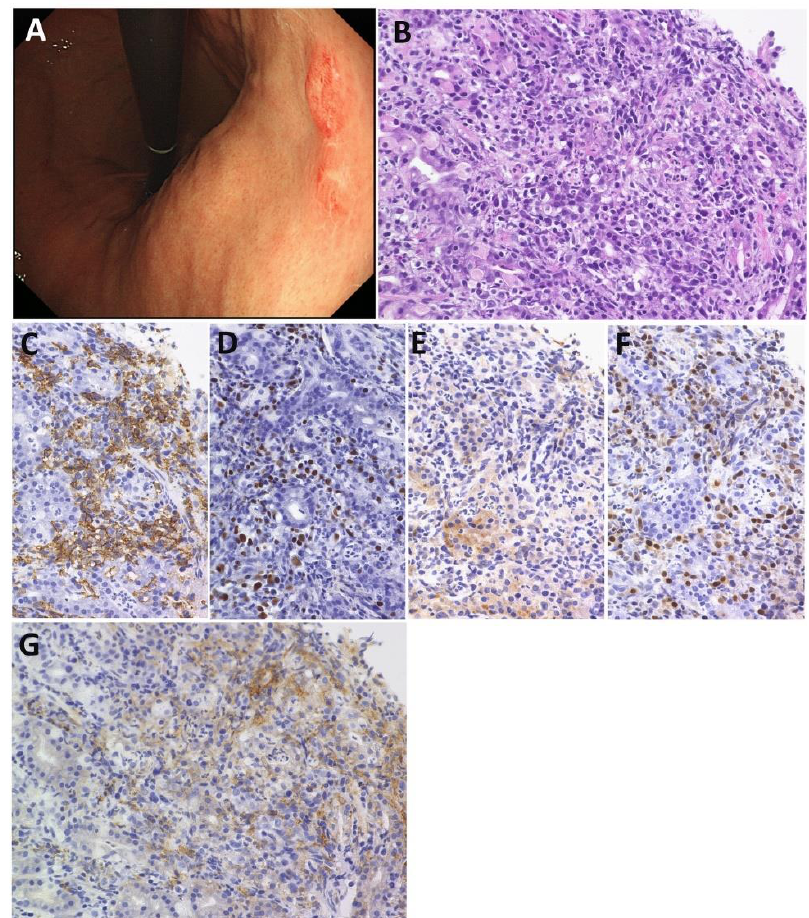
Figure 1. Histological features of EBV-positive mucocutaneous ulcer (EBVMCU). ( A ) Endoscopic image revealing small shallow ulcers in the stomach. ( B ) The infiltrate is polymorphous, containing lymphocytes, histiocytes, and immunoblasts, but not Hodgkin-like cells. ( C ) The scattered large cells were positive for CD20, ( D ) EBER, ( E ) CD30, and ( F ) MUM1. ( G ) PD-L1 is expressed on nonmalignant immune cells, but not on tumor cells. Original magnifications: ×200 ( B – G ). 4. EBV-Positive Diffuse Large B-Cell Lymphoma (EBV + DLBCL) EBV + DLBCL, NOS was first described in Japan, and is defined as an EBV-positive clonal B-cell lymphoid proliferation in the 2017 WHO classification. Other well-defined lymphoma entities, such as lymphomatoid granulomatosis, acute or recent EBV infection, plasmablastic lymphoma and DLBCL associated with chronic inflammation, and EBVMCU, are excluded from this category. 4.1. Clinical Features EBV + DLBCL was originally documented among elderly patients > 60 years of age [6,7]. Most patients present with extranodal, clinically aggressive disease and have no his- tory of immunosuppression. EBV has been reported in 3 – 15% of patients with DLBCL [7 –